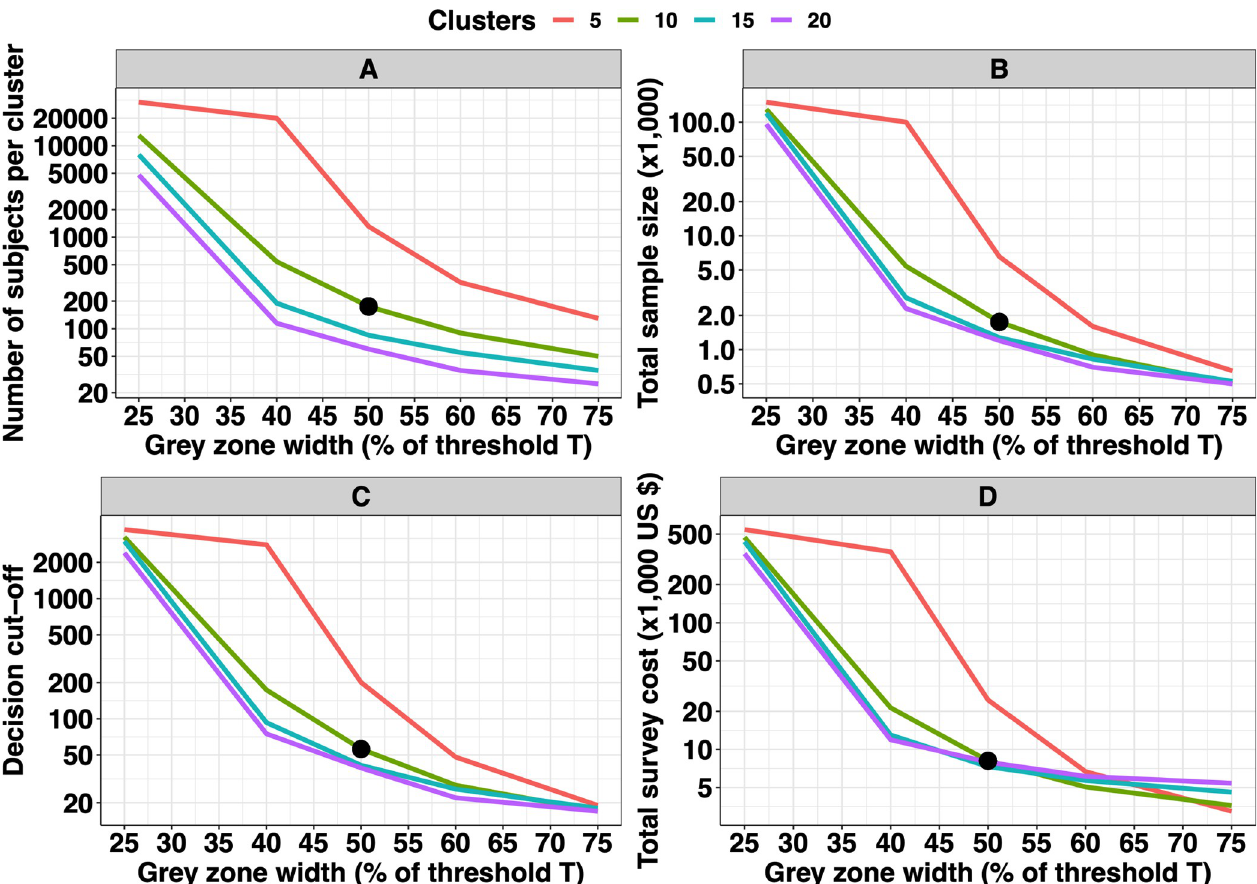
Fig 5. Impact of the width of the grey zone on program decision-making when applying imperfect diagnostics. This figure illustrates the impact of the width of the grey zone on the number of subjects per cluster ( Panel A ), the total number of subjects sampled across n survey design for adequate program decision-making ( E overtreat = 25 % and E undertreat = 5 %) ( Panel B ), the decision threshold c (Panel C), and the associated total survey cost ( Panel D ). We considered program prevalence threshold T of 2%, fixed the intra-cluster correlation ρ diagnostic test D t 1 ( se dt 1 = 80 % and sp dt 1 = 98 %). The width of the grey zone is expressed as a proportion of program prevalence threshold T . The black bullet across the four panels indicates the chosen hypothetical reference grey zone width ( T ± 50 %), which was chosen to further illustrate the impact of the diagnostic performance ( Fig 6 ) and geographical variation in prevalence between clusters on program decision-making ( Fig 7 ), and the relative change in total survey cost based on newer diagnostic tests ( Fig 8 ). All graphs are based on the same set of 10,000 Monte Carlo simulations.